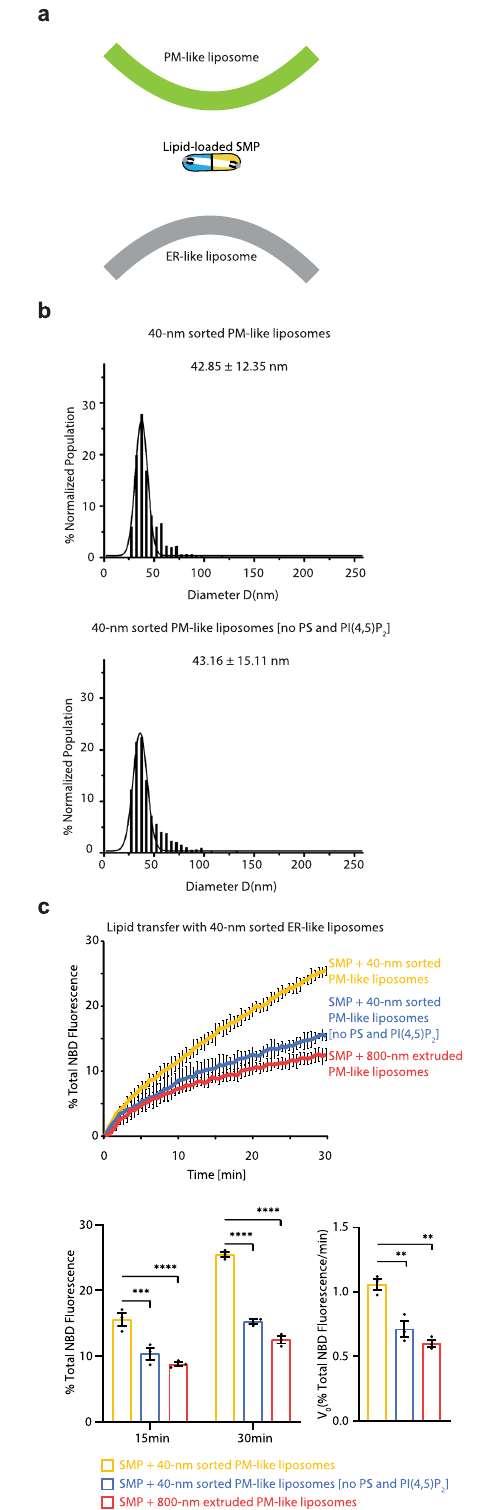
Fig.4|Extrememembranecurvatureandacidiclipidshaveasynergisticeffect on SMP-mediated lipid transfer. a , Schematic representation of SMP-mediated lipid transfer between curved ER-like and curved PM-like liposomes. b , Size dis- tributionsofPM-likeacceptorliposomeswithorwithoutPI(4,5)P 2 andPSprepared from extrusion through fi lters with 30nm pores followed by DNA brick-assisted sorting. Diameters of liposomes were measured from negative-staining TEM ima- ges. Average diameters are presented as mean±SD ( n =1258 and 1153 liposomes from left to right). c , Top, time courses of lipid transfer between ER-like donor liposomesanddistinctlysizedPM-likeacceptorliposomeswithorwithoutPI(4,5)P 2 and PS in the presence of SMP at 37°C as assessed by dequenching of NBD-PE fl uorescence. Bottom left, quanti fi cations ofNBD fl uorescenceafter incubation for 15min or 30min. Bottom right, initial transfer rates. Data are presented as mean±SD( n =3independentexperiments).**P<0.01,***P<0.001,****P<0.0001 bytwo-wayANOVAwithBonferroni ’ smultiplecomparisonstest(bottomleft)orby one-way ANOVA with Bonferroni ’ s multiple comparisons test (bottom right). P values:2.3×10 − 4 (bottomleft,15min),2.4×10 − 7 (bottomleft,30min),and5.0×10 − 3 (bottom right) for [(SMP+40-nm sorted PM-like liposomes) vs (SMP+40-nm sor- ted PM-like liposomes no PS and PIP 2 )]; 1.8×10 − 5 (bottom left, 15min), 1.6 × 10 − 8 (bottomleft,15min),and1.2×10 − 3 (bottomright)for[(SMP+40-nmsortedPM-like liposomes) vs (SMP+800-nm extruded PM-like liposomes)]. Source data are pro- vided as a Source Data fi